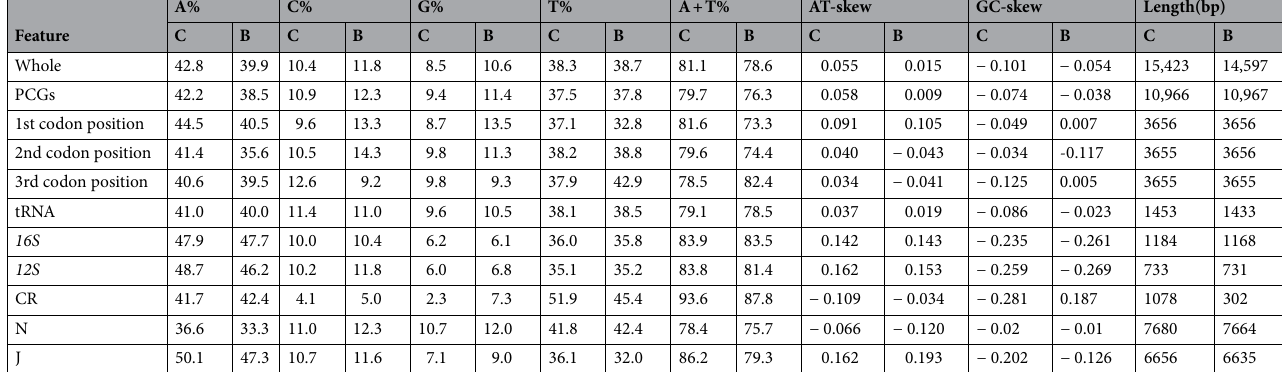
Table 3. Nucleotide composition of the C. cassiae (C) and C. bimaculata (B)